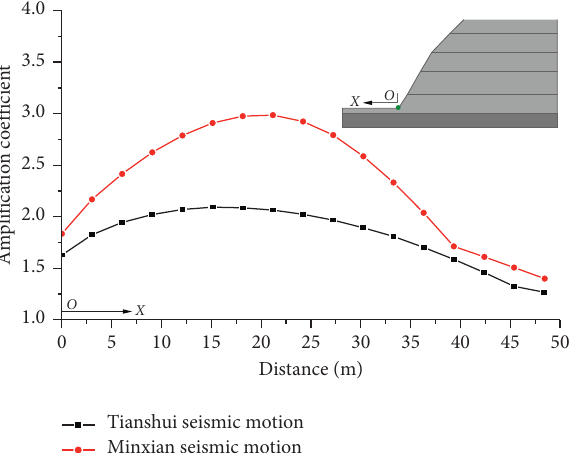
Figure 11: Distribution of the amplification coefficient with the distance.